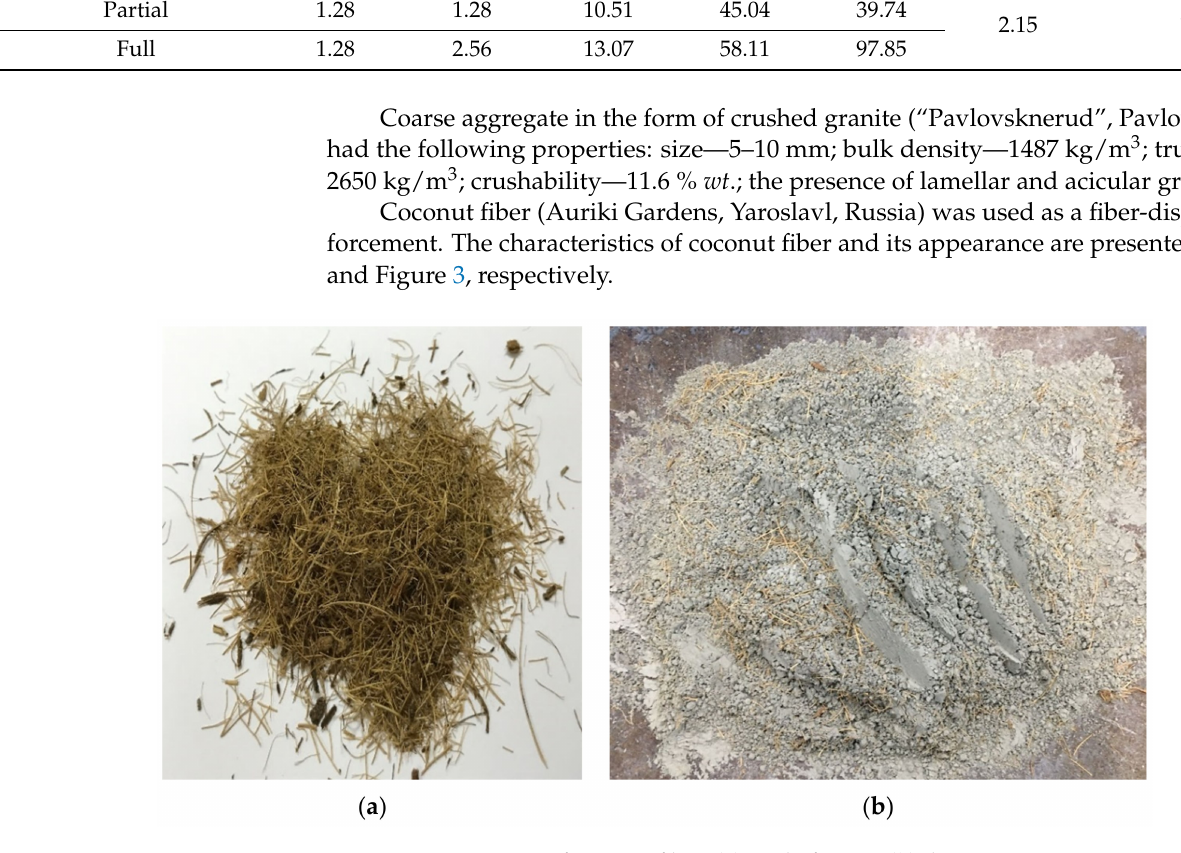
Figure 3. Appearance of coconut fiber: ( a ) ready for use; ( b ) dry